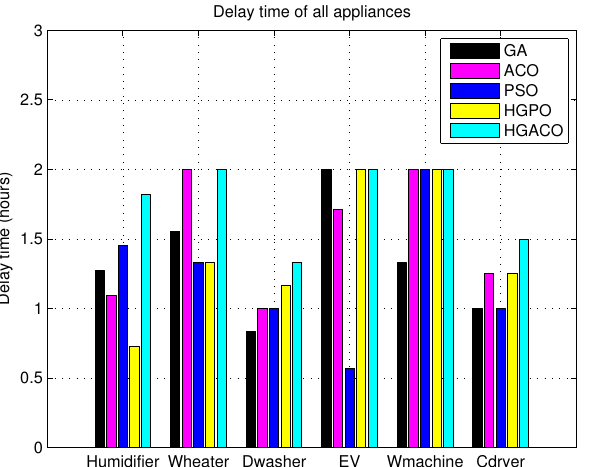
Figure 21. Delay faced by consumers while operating appliances according to power usage schedule generated by proposed and existing